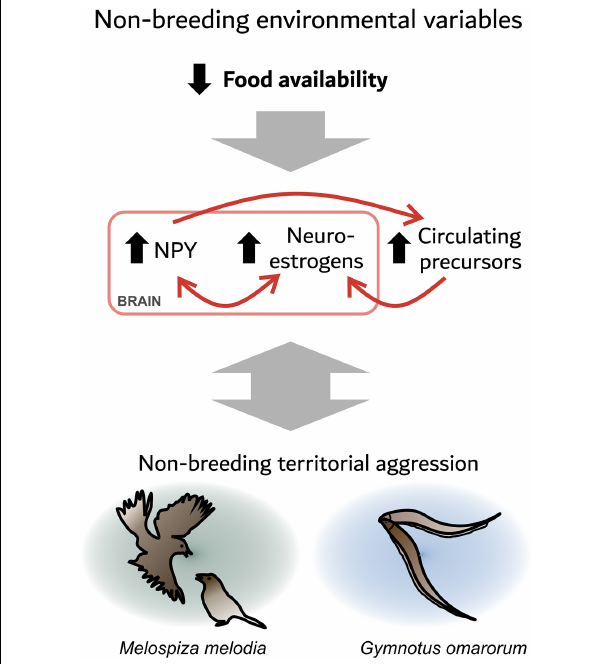
FIGURE 1 | Food availability may be an environmental factor that modulates the expression of territorial aggression through neuropeptide Y (NPY) and neurosteroid signaling. A seasonal decrease in food availability increases NPY in the social behavior network (SBN). NPY may stimulate non-breeding territorial aggression directly, or via the production of neuroestrogens. In addition, a decrease in food availability may increase circulating precursors to neuroestrogens. Agonistic encounters also affect the neuroendocrine state as dominants show an increase in NPY and aromatase expression, which may reinforce the defense of the foraging